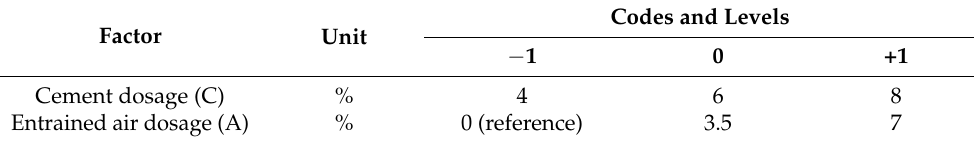
Table 4. Factors investigated and coding of the three levels investigated.